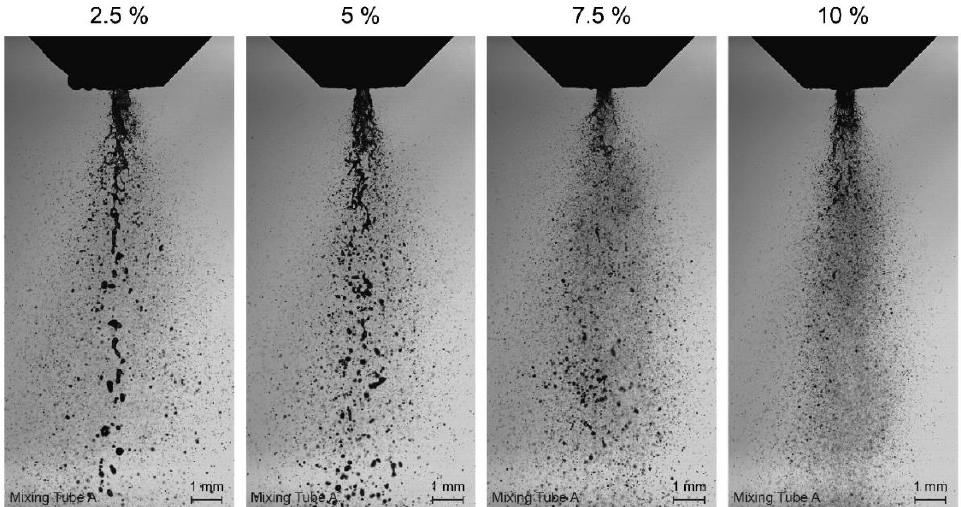
Figure 4. High-speed visualization of droplet size distribution for gas-to-liquid ratios 2.5 to 10%. Images for mixing tube A are shown as example for the influence of the gas-to-liquid ratio.